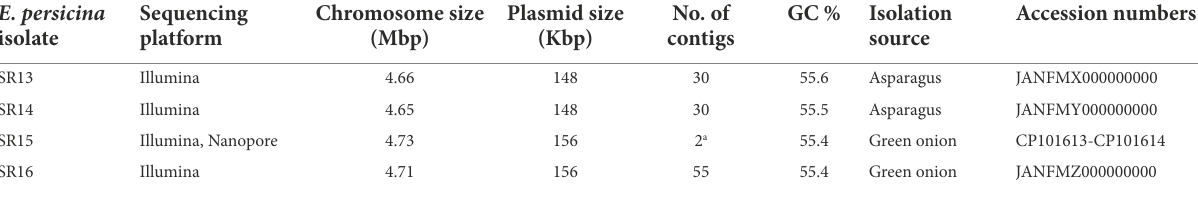
and Pectobacterium versatile strains SR1 and SR12 (Wasendorf et al., 2022), and no pink pigmentation was observed (Figure 4).